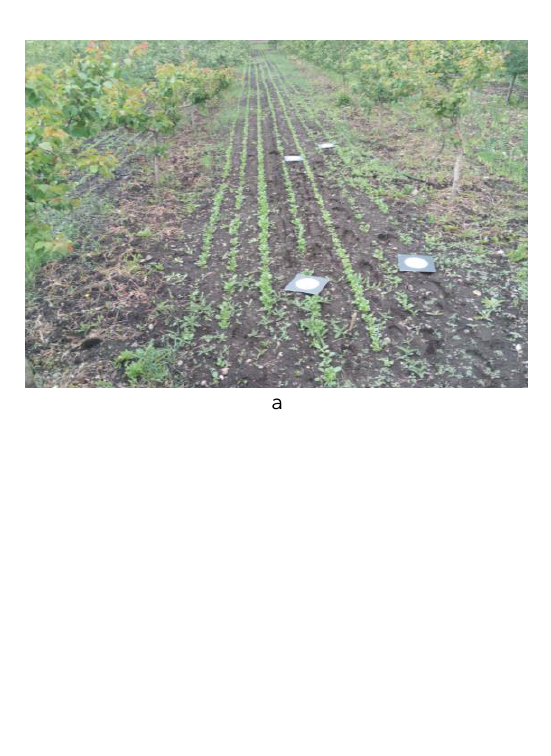
Figure 6: a) Intensity profiles of the spectral bands across a section of the checkerboard pictured in Figure 5c; b) Intensity profiles of the spectral bands across a section of the background wall in Figure 5a (transitioning from sunny to shaded areas)